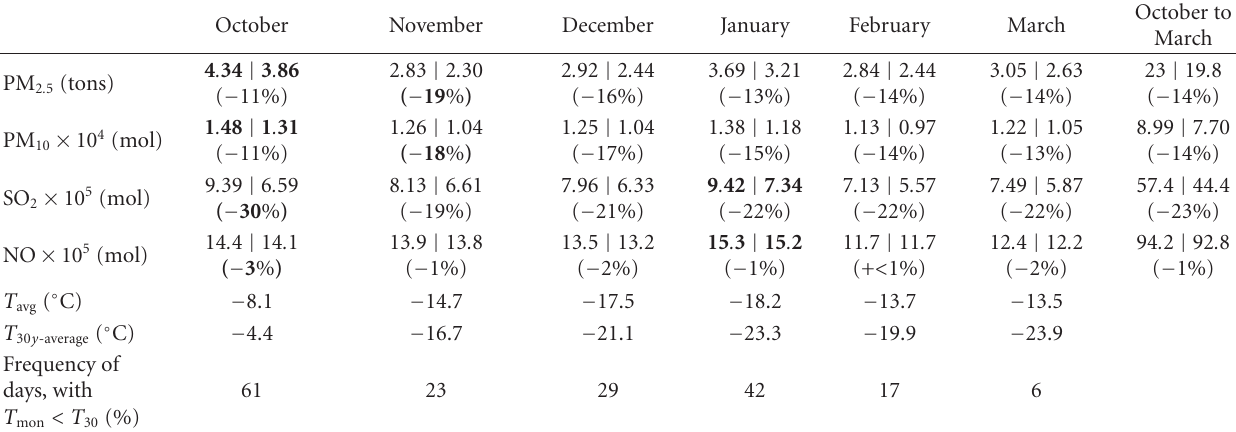
Table 1: Total emissions of REF (first value) and LSF (second value) and percent reduction (in brackets) in the nonattainment area, and monthly mean temperatures ( T mon ) and frequency of days with temperatures lower than the 1971–2000 mean ( T 30 ). Bold values indicate significant